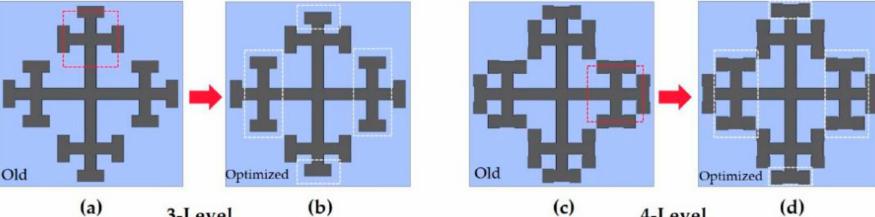
Figure 4. Three-level and four-level fractals, self-similar structures and optimized structures are placed in equal proportions. ( a ) The old three-level fractal structure. ( b ) The optimized three-level fractal structure. ( c ) The old four-level fractal structure. ( d ) The optimized four-level fractal